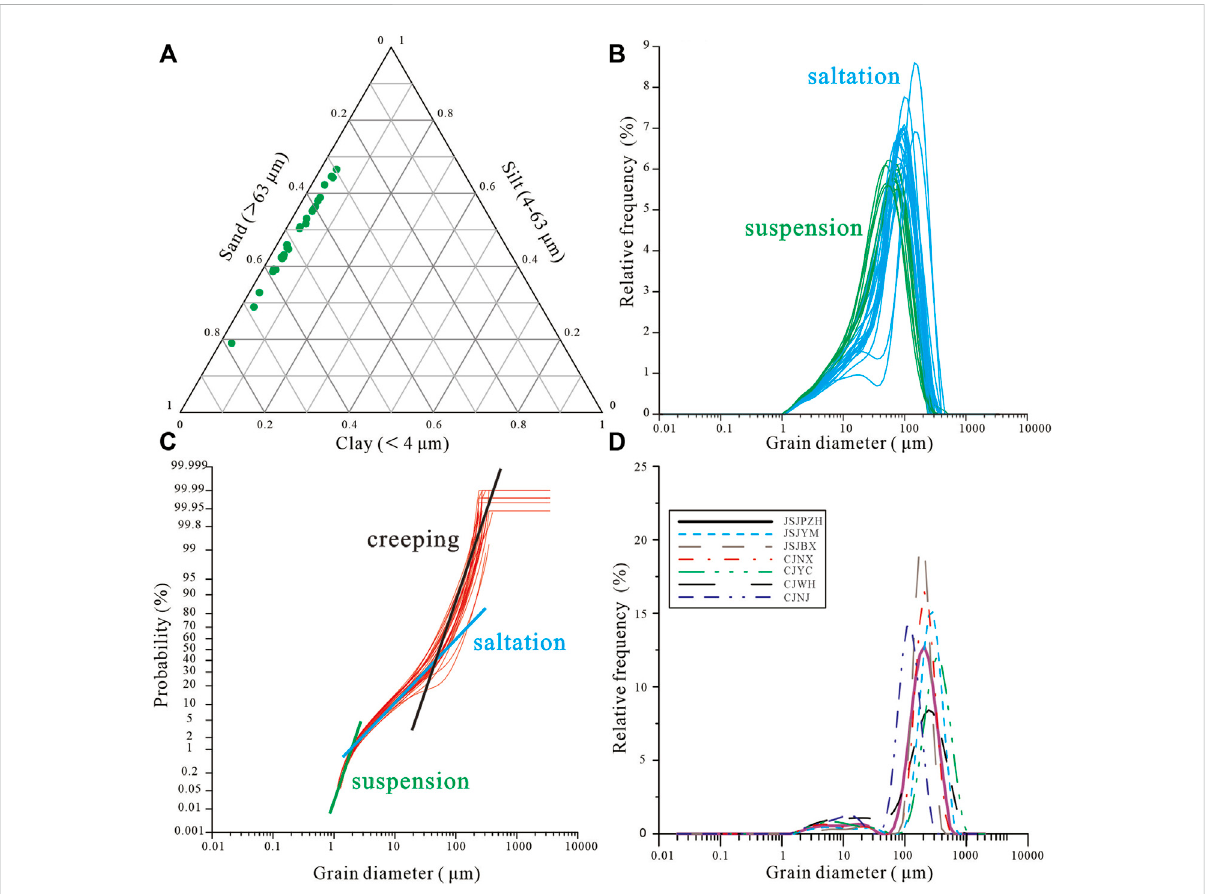
FIGURE 7 Grain size characteristics of diluvium from Baige dammed lake (A – C) and other normal Yangtze deposits (D) . (A) Shepard ternary plot of grain size distribution. (B,D) Relative frequency plots of grain size distribution. (C) Probability plot of grain size distribution.